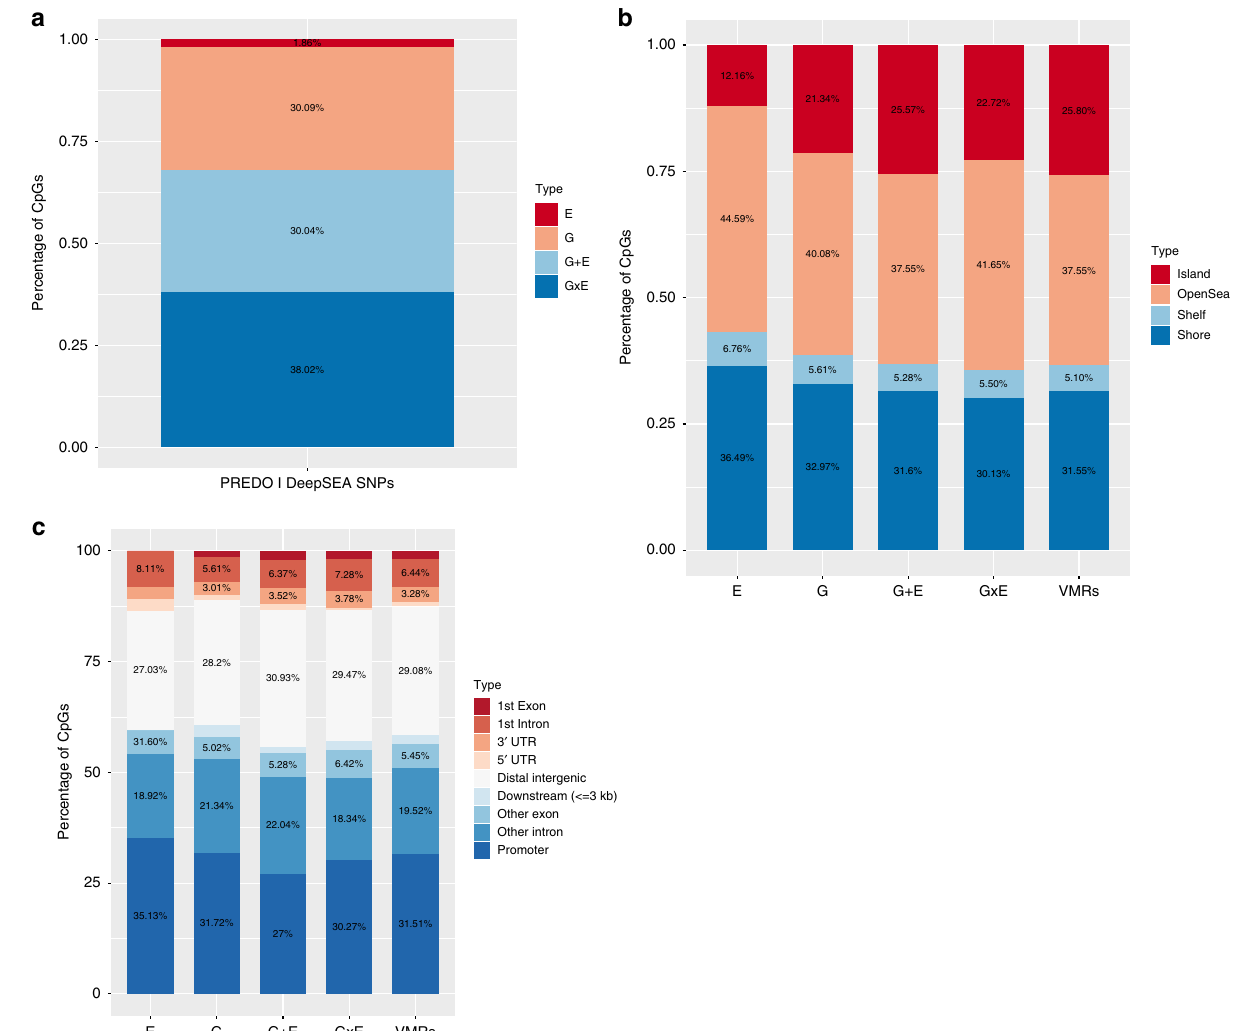
Fig. 3 VMR analysis in DeepSEA annotated SNPs in PREDO I dataset. a Percentage of models (G, E, GxE or G + E) with the lowest AIC explaining variable DNA methylation using the PREDO I dataset with DeepSEA annotated SNPs. b Distribution of the locations of all VMRs and tagVMRs with best model E, G, G + E and GxE on the 450k array using only DeepSEA variants in relationship to CpG-Islands based on the Illumina 450 K annotation. c Distribution of gene-centric locations of all VMRs and tagVMRs with best model E, G, G + E and GxE on the 450k array using only DeepSEA